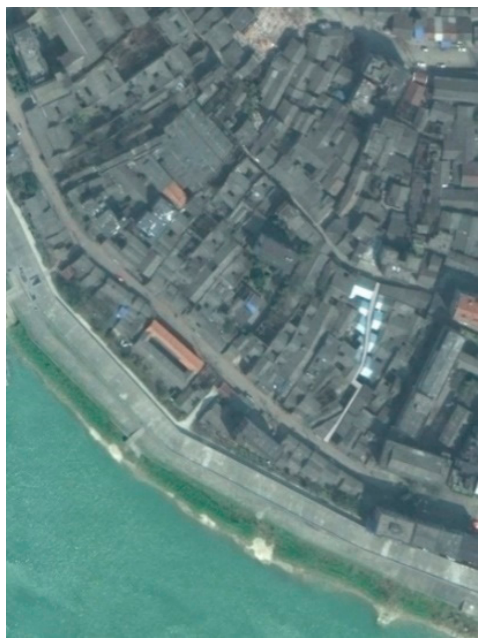
Figure 3. Cold-Lane seen from a satellite image (from Google Map).